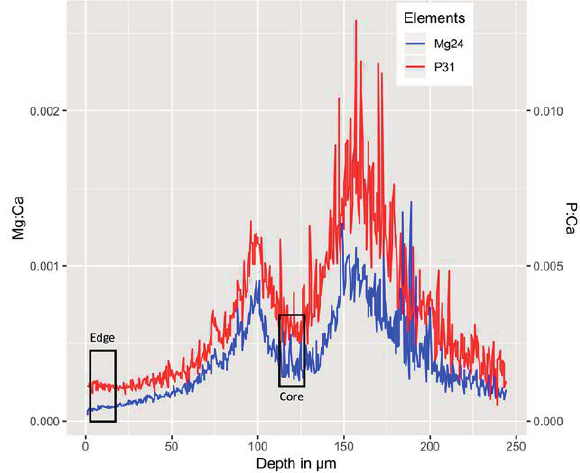
Fig. 2. – Mg:Ca and P:Ca ratios in relation to the ablation depth of the otolith of Engraulis ringens . Core and edge regions that were averaged for natal origin analyses are indicated.